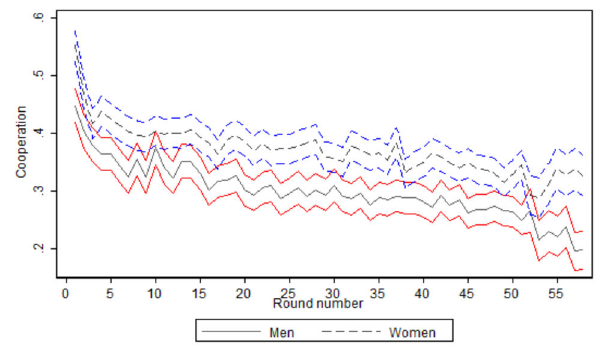
Figure 3. Mean cooperation, by round and gender. [ Notes : cooperation is defined as the mean value of a dummy variable that takes value “1” if the individual cooperates in the round of reference, and takes value “0· for defection. Round number goes from 1 to 58. Confidence intervals (CI) are defined at the 95% level. Red lines show the CI for men, and blue lines show the CI for